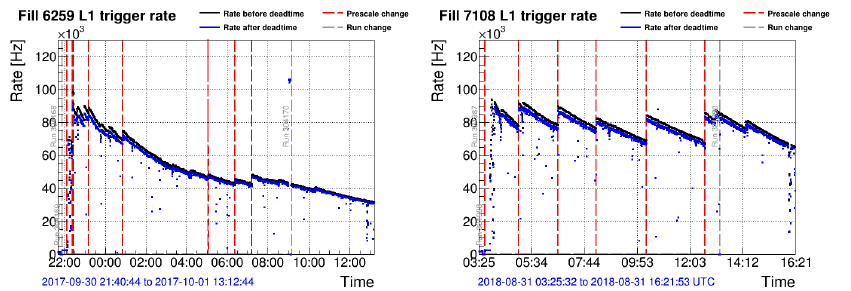
Figure 1. Rate of the CMS L1 trigger (blue data points), as a function of time, during an LHC fill in ( left panel ) 2017 and ( right panel ) 2018. The time intervals cover 13–15 hours. Changes in the run number and settings (prescale column) are indicated by vertical grey and red dashed lines, respectively. Taken from Ref. [25].